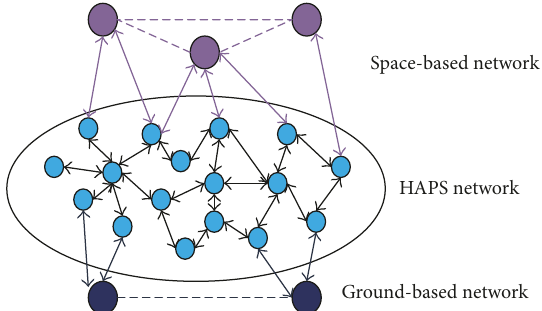
Figure 1: The abstract model of the near space HAPS network system.